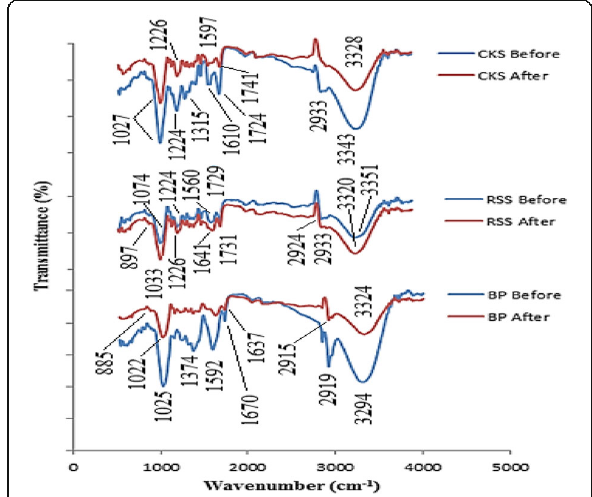
Fig. 1 FT-IR spectrum of CKS, RSS, and BP before and after